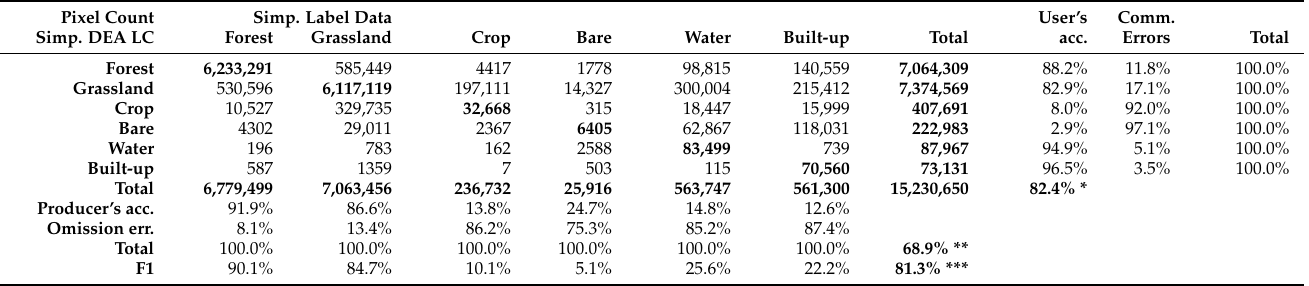
Table 9. Simplified DEA Land Cover vs. simplified label data for 2018. OA = 82%, Kappa = 69% and weighted-mean F1 = 81%. Excludes No data